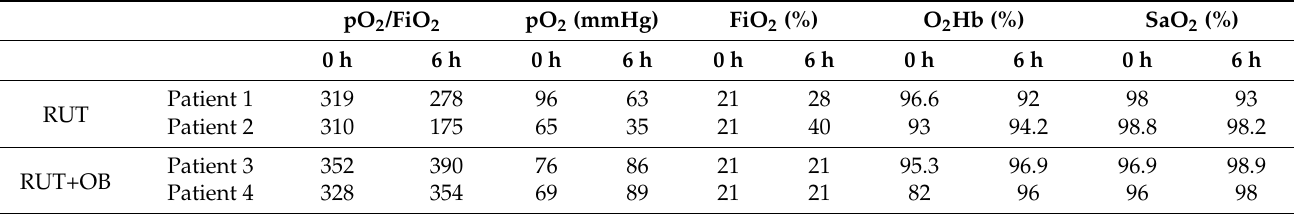
Table 2. Blood parameters obtained by routine laboratory analysis at 6 h from the start of treatment. Representative patients belonging to both groups were reported.